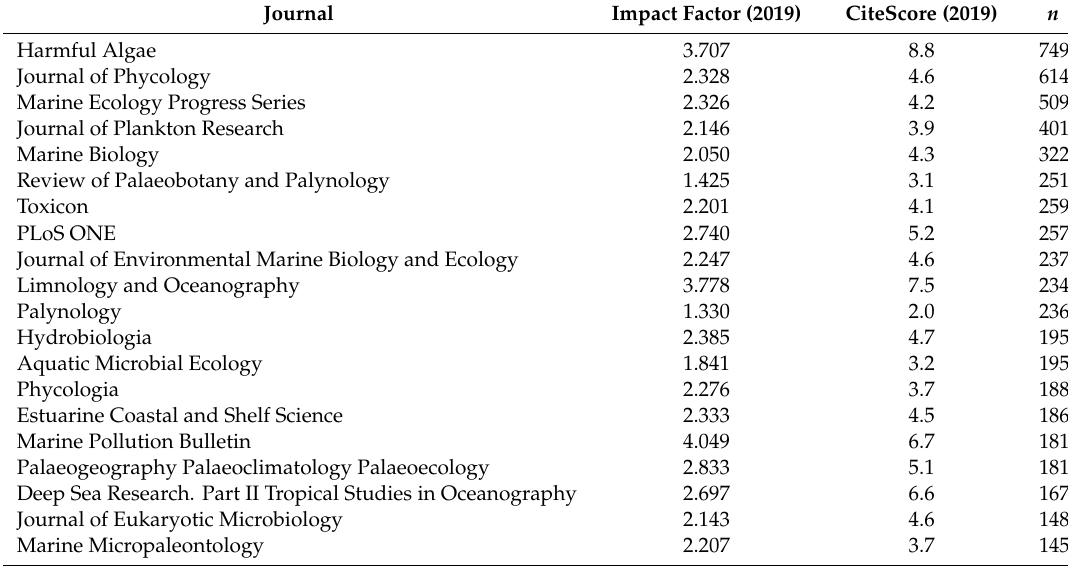
Table 3. Top 20 journals with published dinoflagellate research with the associated Impact Factor, CiteScore and number of documents ( n ).